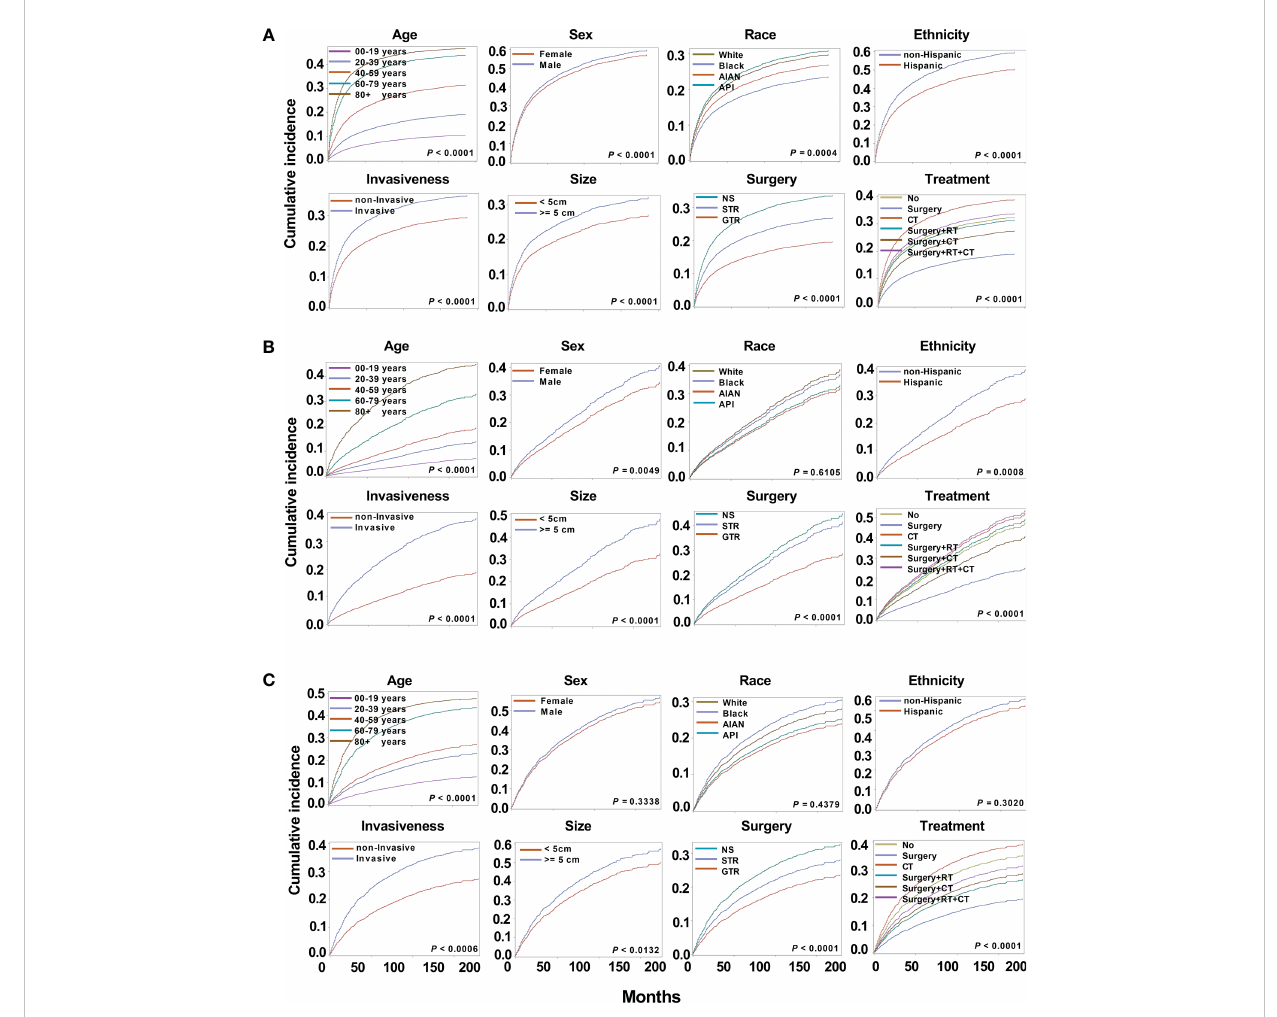
FIGURE 4 Cumulative incidence curves for astrocytoma, oligodendrogliomas, and mixed gliomas. The subsequent plots present fraction of the population that has died from their astrocytoma (A) , oligodendrogliomas (B) , and mixed gliomas (C) by age, sex, race, ethnicity, invasiveness, tumor size, surgery, and treatment